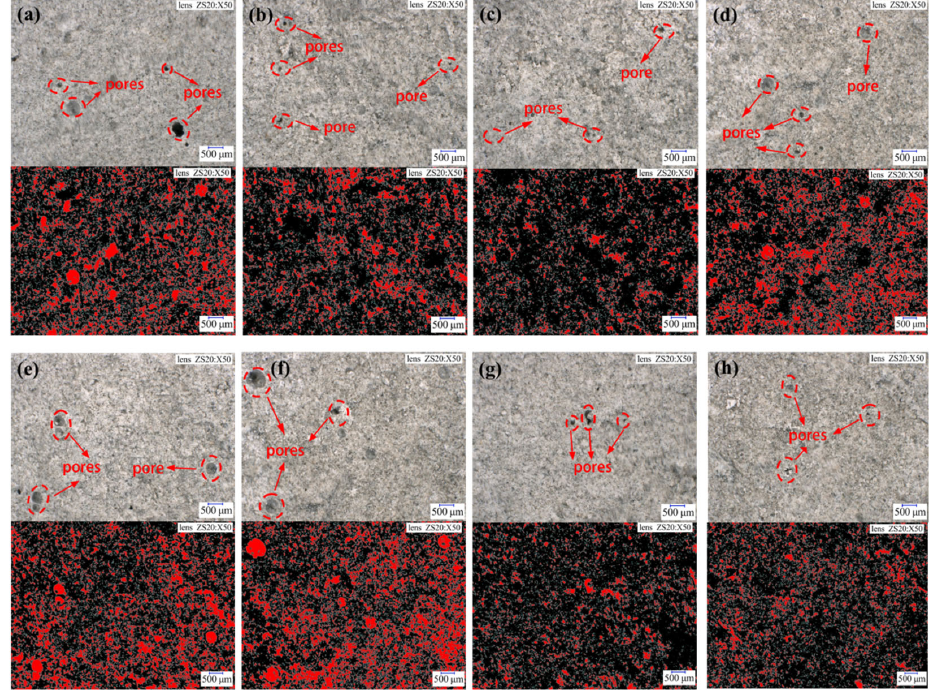
Figure 5. Microscopic morphology and pore distribution of net cement paste under different conditions: ( a ) 20 °C 1d PC; ( b ) 20 °C 2d PC; ( c ) 20 °C 3d PC; ( d ) 20 °C 1d UC = 2%; ( e ) 20 °C 1d UC = 5%; ( f ) 20 °C 1d UC = 8%; ( g ) 40 °C 1d PC; ( h ) 60 °C 1d PC.